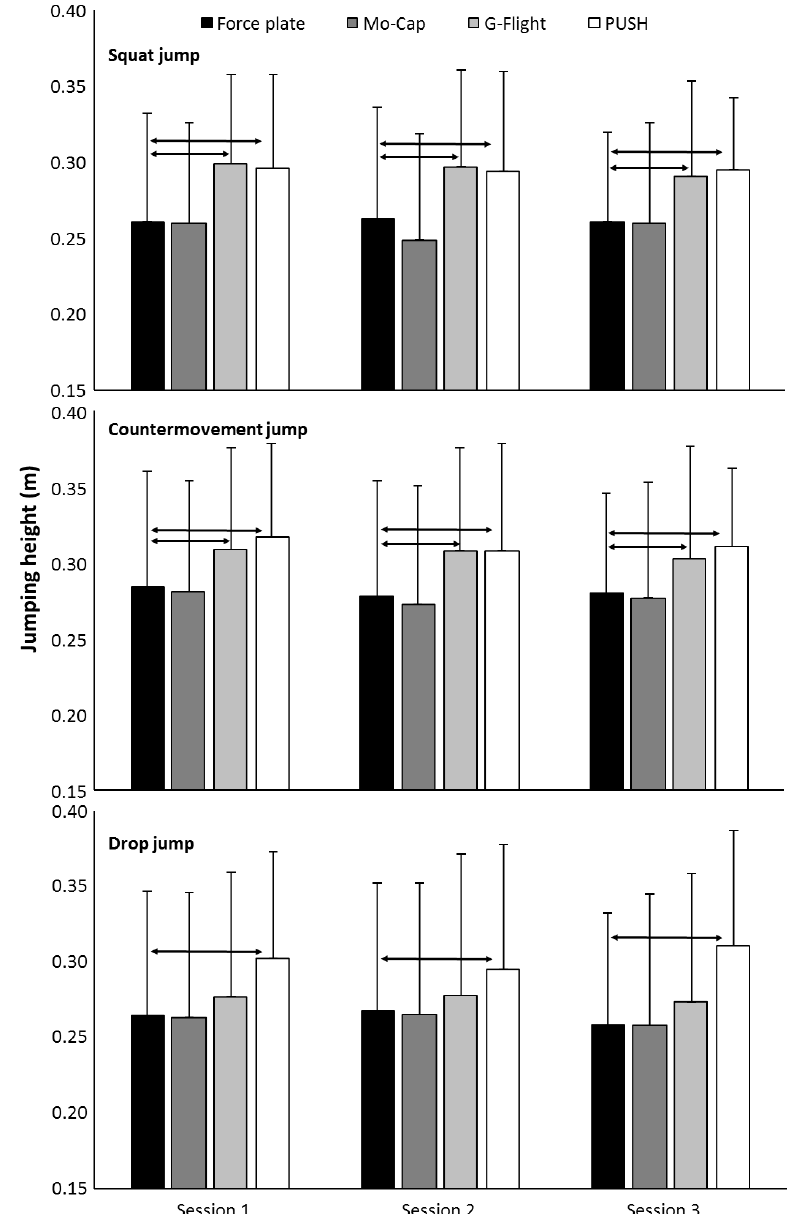
Figure 2. Mean ( ± SD) jump height per session recorded by force-plate, Mo-Cap, G-Flight, and PUSH across squat, countermovement, and drop jumps. Arrows denote p < 0.05.